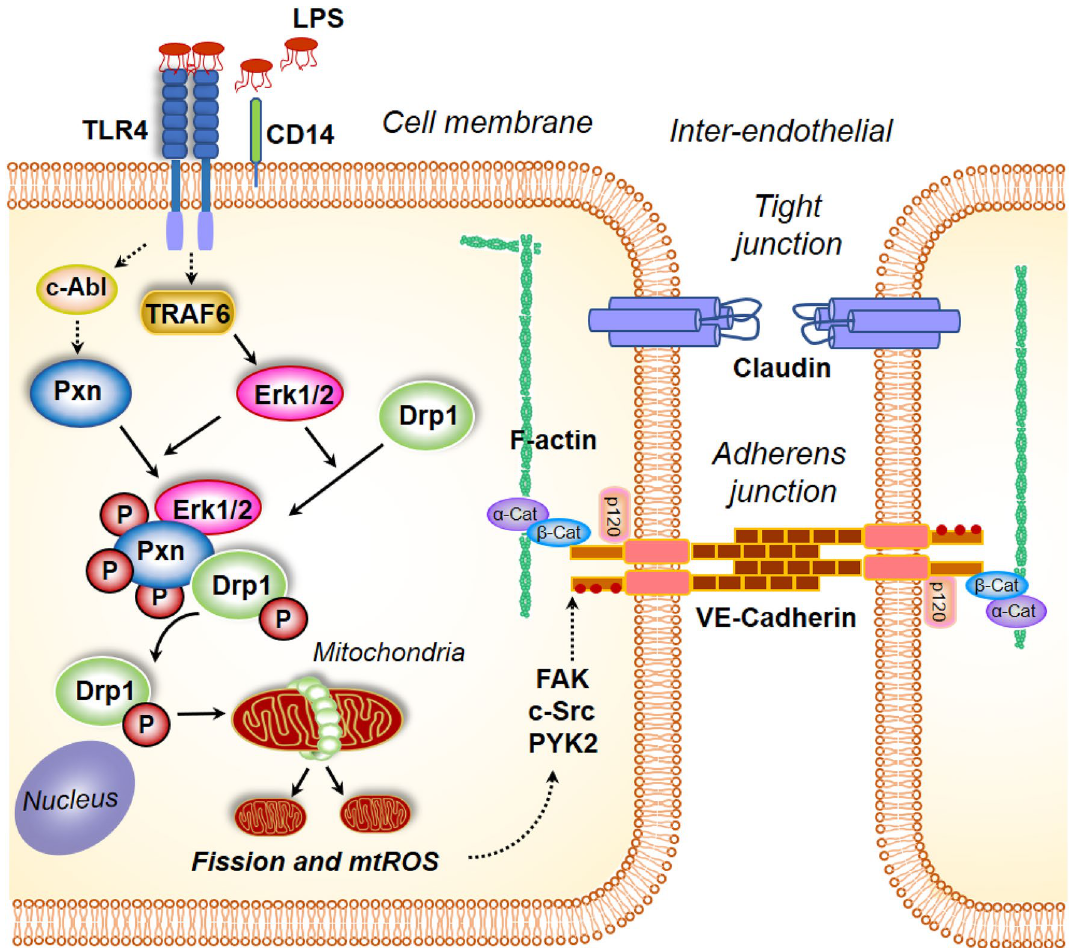
in changes in paxillin phosphorylation, which is essential for DRP1 phosphorylation by ERK. Activation of DRP1 results in its translocation to mitochondria resulting in mitochondrial fission accompanied by enhanced mitochondrial ROS. Blocking paxillin or DRP1 phosphorylation attenuates mitochondrial ROS generation and VE-cadherin phosphorylation status. Similarly, blocking mitochondrial ROS attenuated LPS-induced VE-cadherin phosphorylation and endothelial